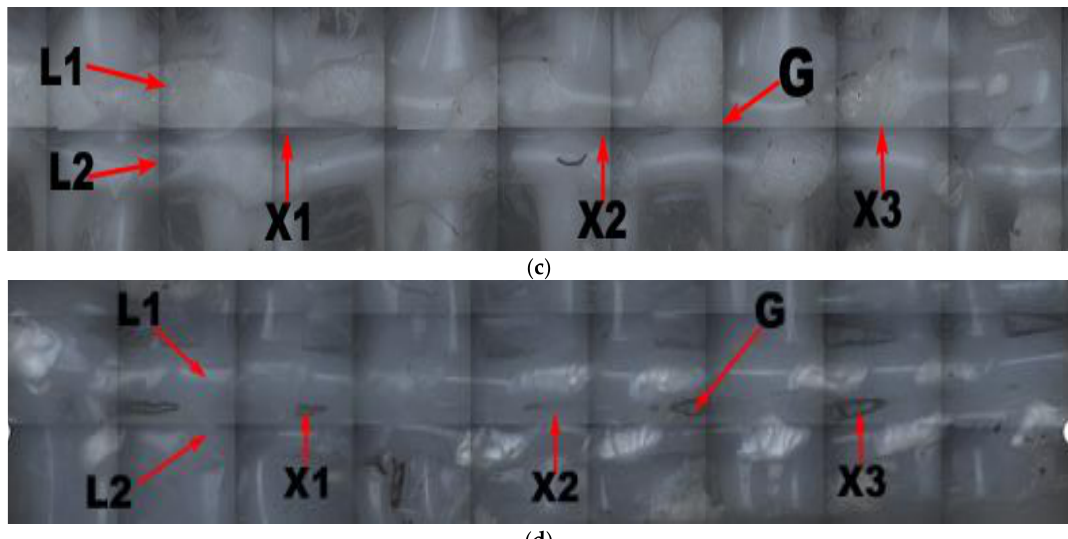
Figure 13. Two adjacent raster images of printed components under different conditions: ( a ) 70% grid support density and grating of z = 0.08; ( b ) 90% grid support density and grating of z = 0.08; ( c ) 70% grid support density and grating of z = 0.14; ( d ) 90% grid support density and grating of z = 0.14.